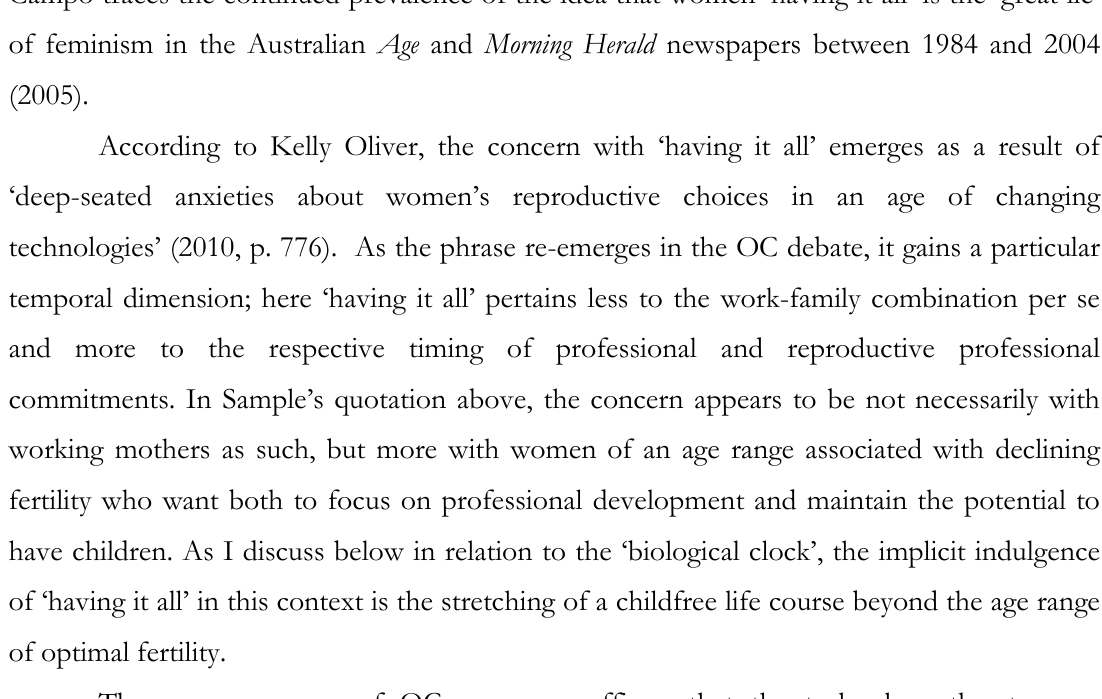
Lucy van de Wiel, For Whom The Clock Ticks: Reproductive Ageing and Egg Freezing in Dutch and British News